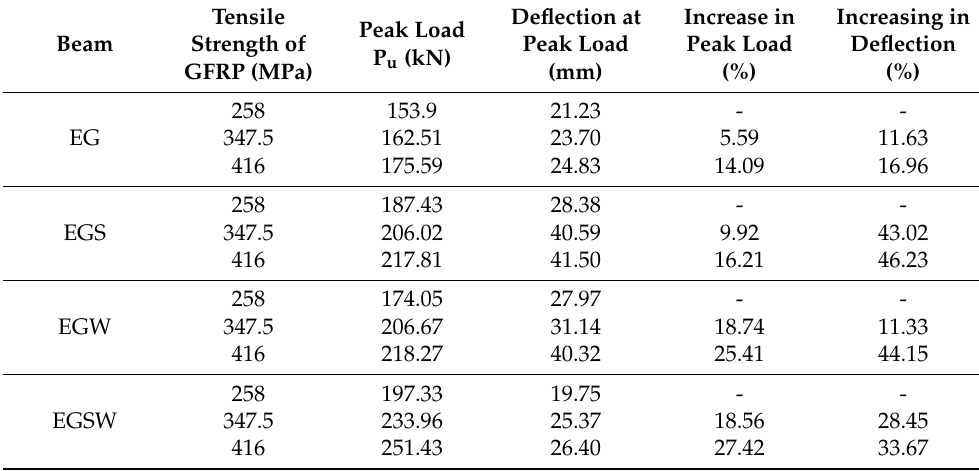
Table 10. Effect of the GFRP tensile